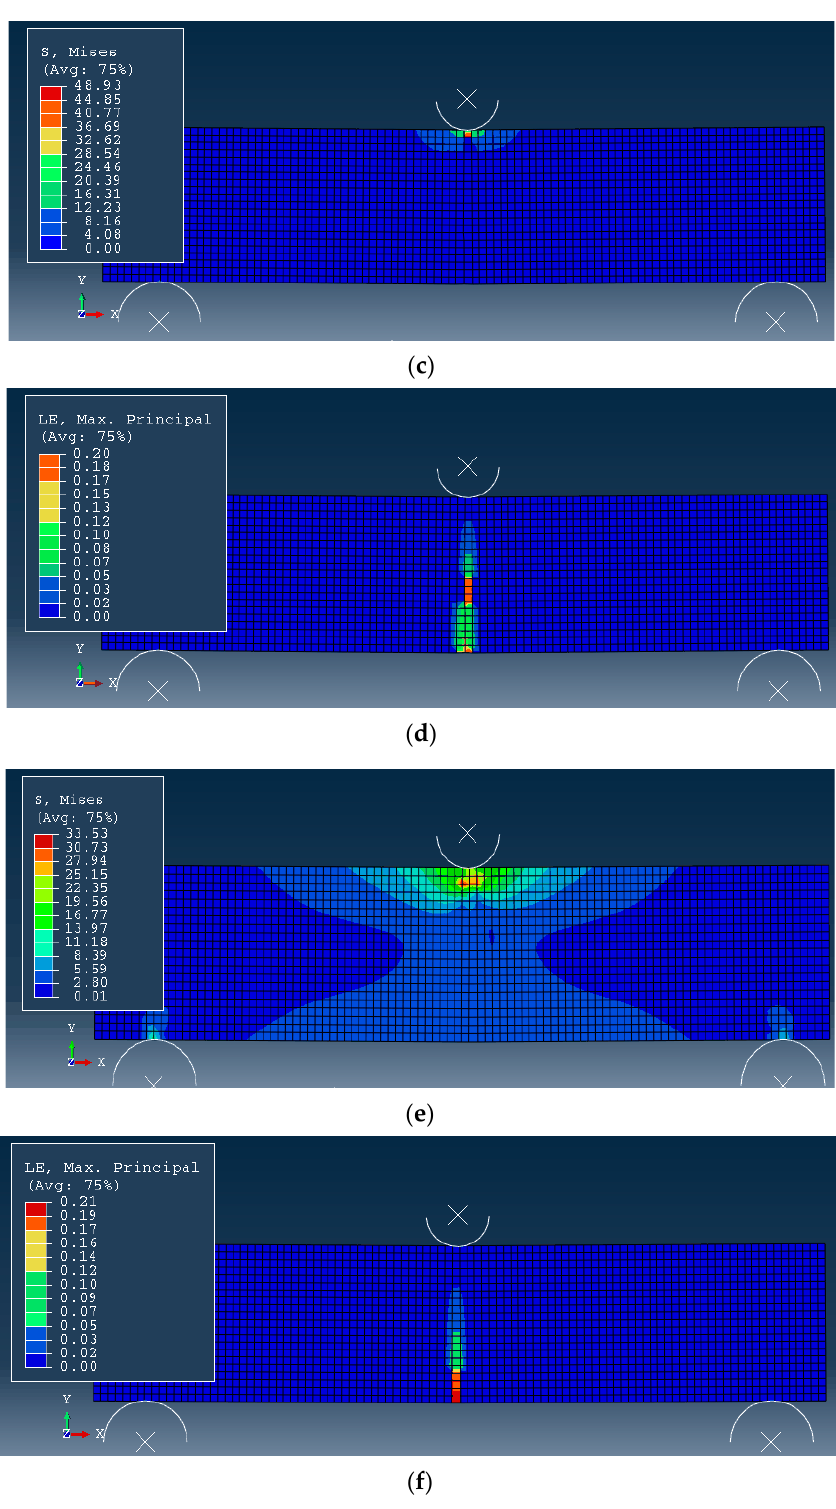
Figure 7. Numerical calculation results of fibre concrete specimens obtained (view from Abaqus program): ( a ) A 1 (effective stresses), ( b ) A 1 ( first principal strain), ( c ) A 2 (effective stresses), ( d ) A 2